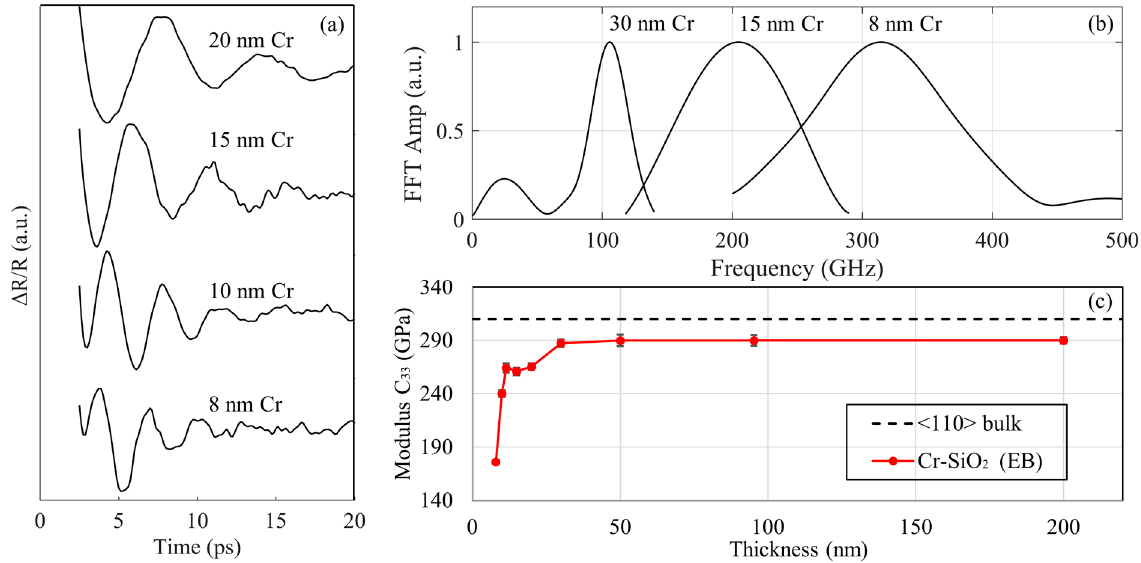
Figure 3. ( a ): The breathing mode vibrations, ( b ): the corresponding Fourier spectra, and ( c ): the out-of-plane elastic modulus C 33 of Cr films vaporized on the SiO 2 substrate by EB. The broken line denotes the modulus of the monocrystal bulk Cr along the <110> direction.